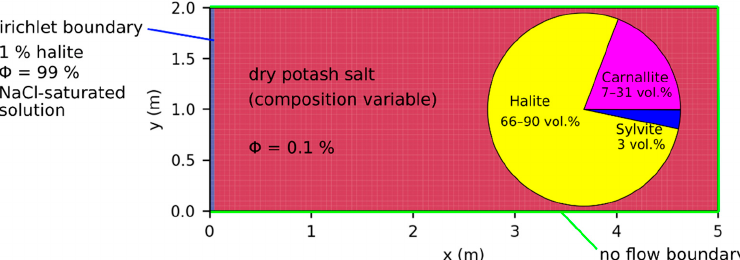
Figure 6. Initial and boundary conditions: the inflow region is prescribed by a Dirichlet boundary (blue line); all other boundaries are impermeable (green lines); the models are initialised with dry, homogeneous rock of varying mineral contents (following the scenario description).